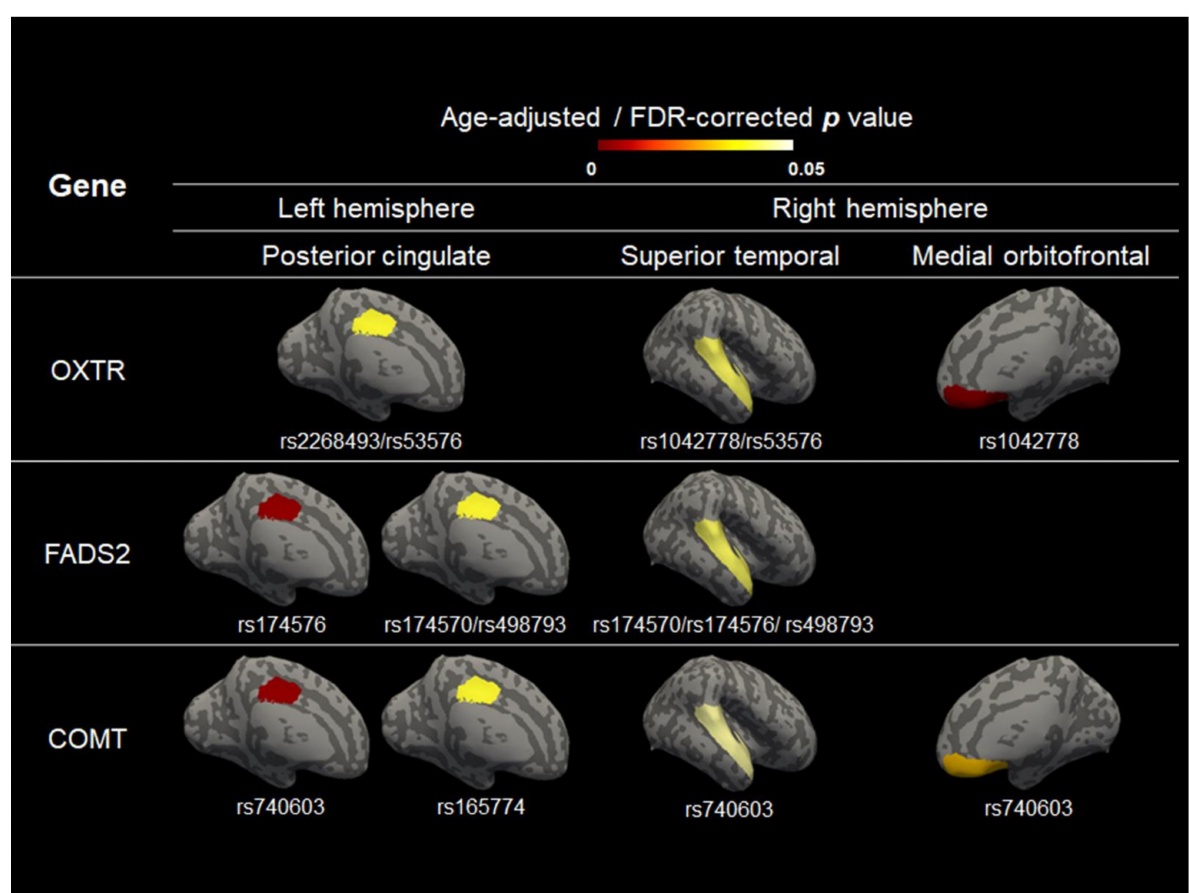
Figure 3. The significant regions of the brain curvature associated with OXTR, FADS2, and